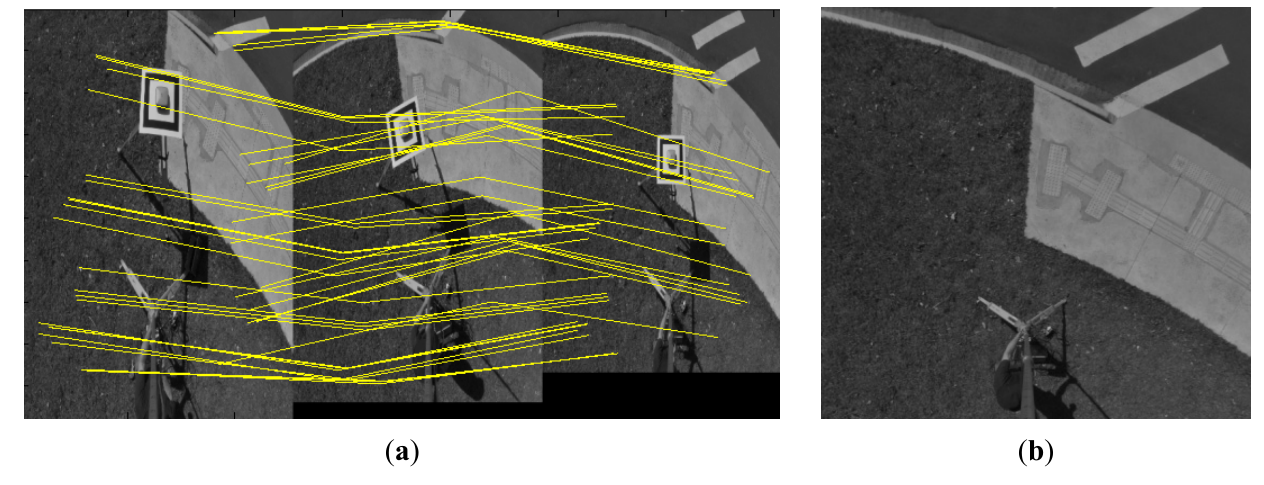
( b ) ortho-image generated for the central area without the control